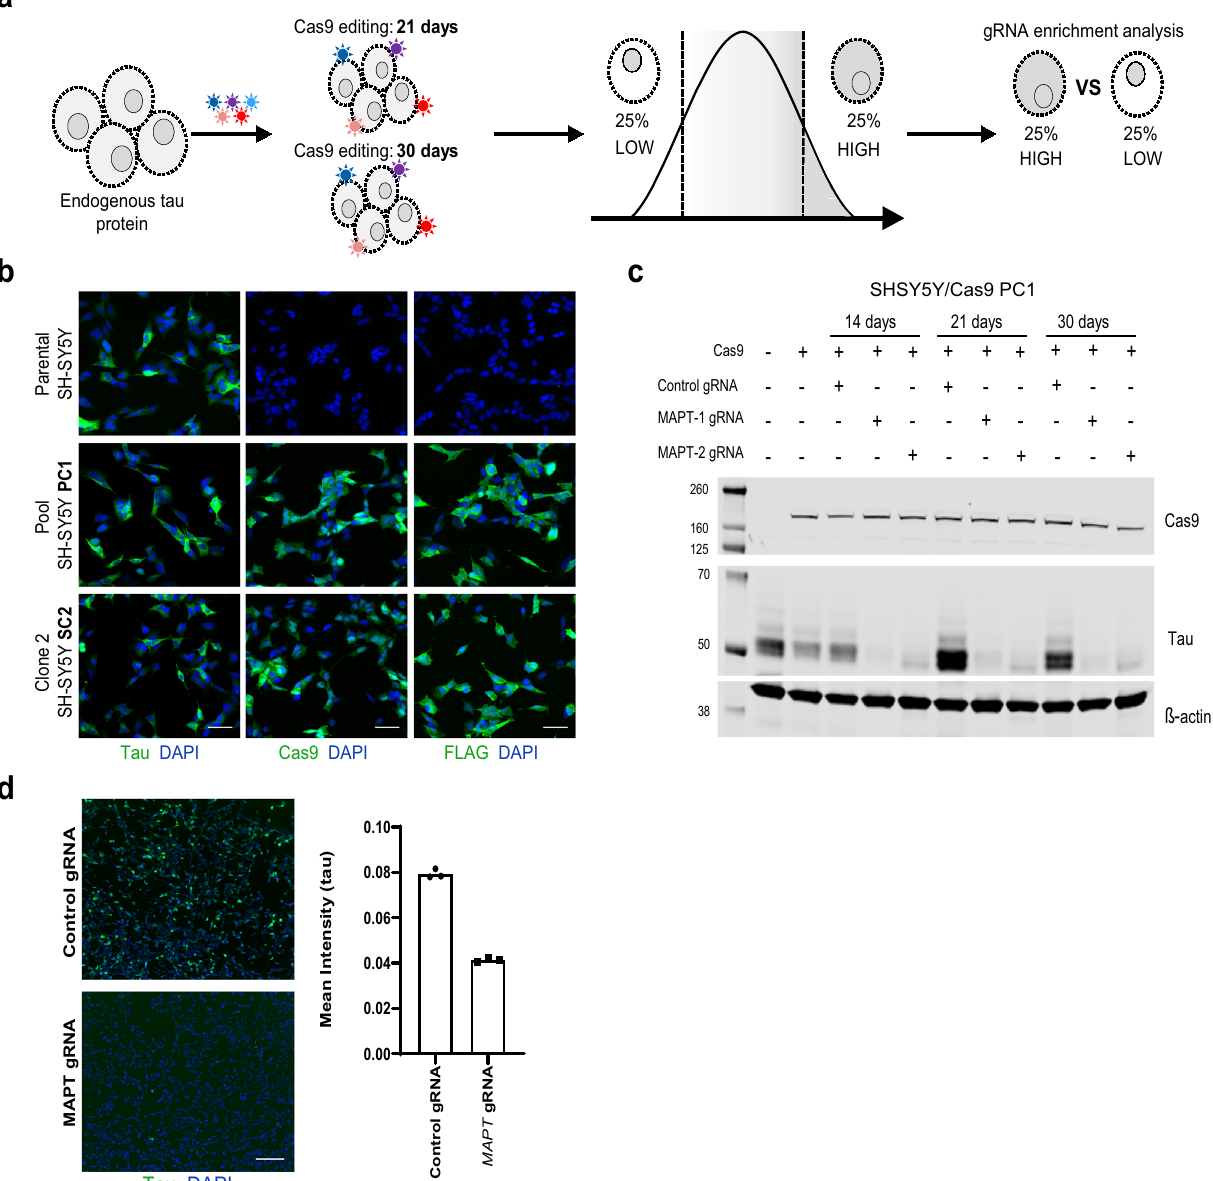
Fig. 1 Characterization of SH-SHY5Y cell lines expressing Cas9. a Schematic representation of primary genome-wide screen performed in SH-SY5Y cells expressing Cas9. b Immunocytochemistry of endogenous tau (SP70), Cas9 and FLAG proteins in parental and stable cell lines expressing Cas9. Pooled cells (PC1) and single clones (SC2) are depicted. Scale bar represents 50 µ m. c Tau (SP70) and Cas9 western blot analysis on SH-SH5Y/Cas9 (PC1) cells infected with control or MAPT gRNAs for 14, 21, or 30 days of editing. d Immunocytochemistry of endogenous tau in SH-SH5Y/Cas9 (PC1) cells infected with control or MAPT gRNAs for 7 days of editing. Scale bars represent 200 µ m. Data is represented as mean fl uorescence intensity ± SEM. Control is a non-target